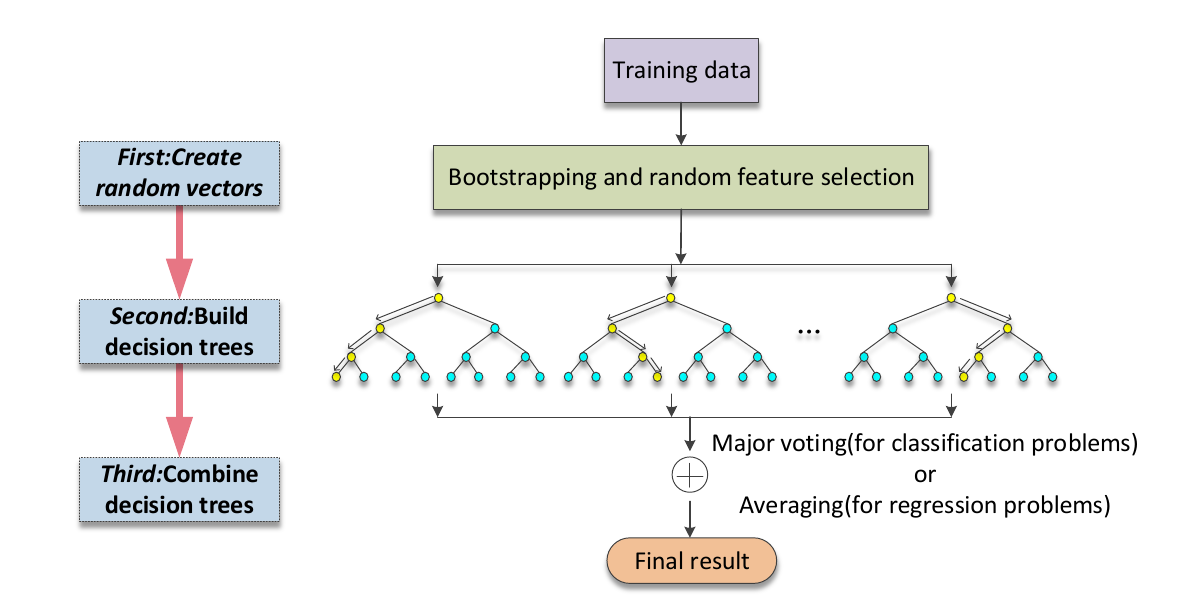
Figure 4. Illustration of random forest algorithm. Source: [35,48].